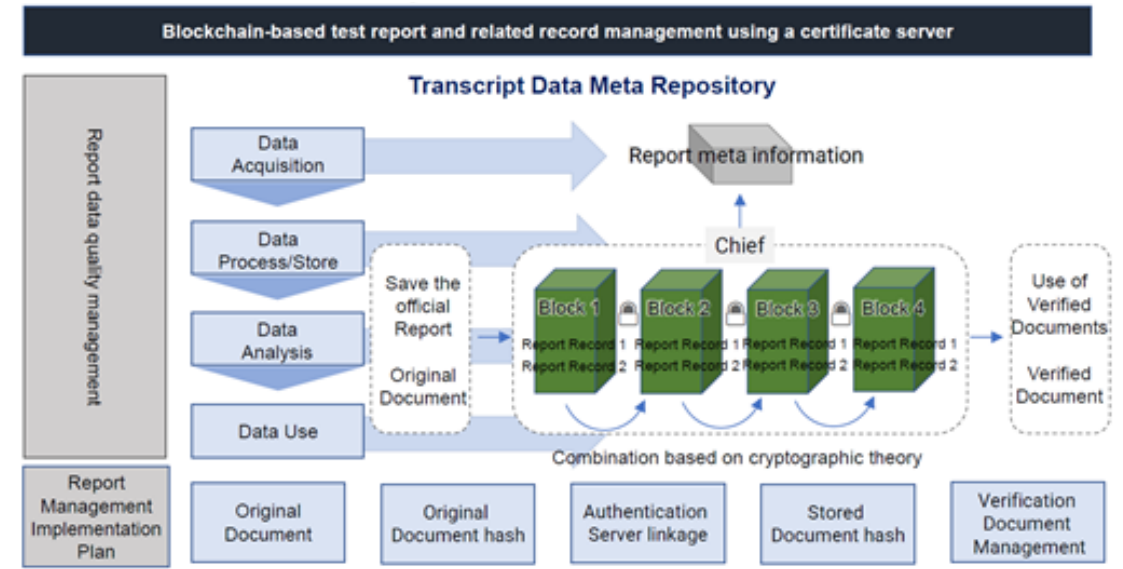
Figure 5. Verification of electronic document management system for public records using block- chain.